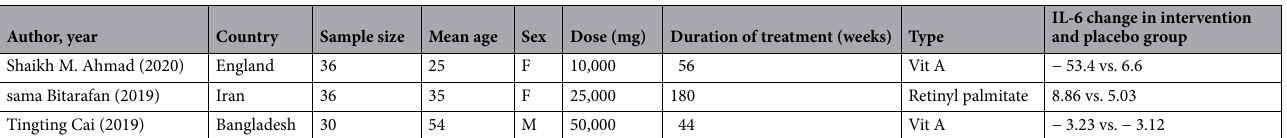
Table 3. The characterized of studies that included IL-6 analysis. Summary of clinical trials on the effects of vitamin A supplementation on inflammatory biomarker (IL-6). IL-6 interleukin 6, M male, F female, a changes in cytokine concentrations are presented by common units for IL-6